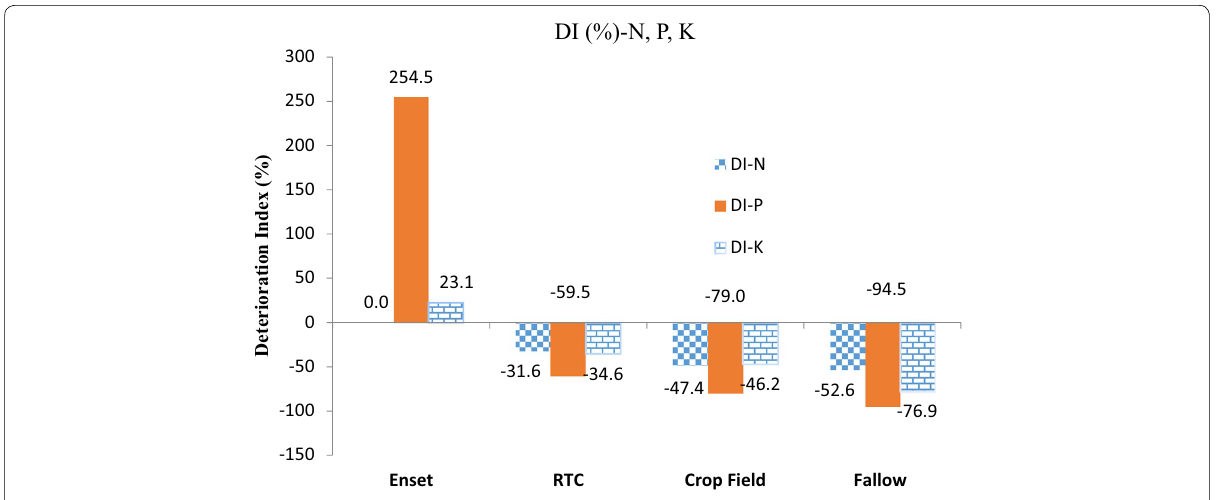
Fig. 4 Deterioration index (DI) (%) of macro nutrients (N, P and K) on different